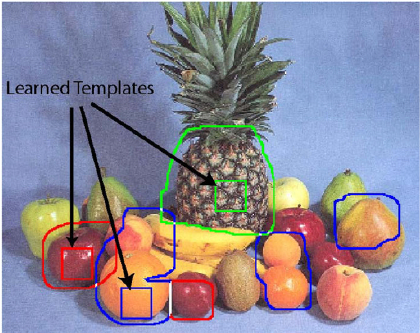
Figure 18: Fruit identification (using the processing core of the chip). The multimodal distribution of the pineapple eliminates mis- classifications.